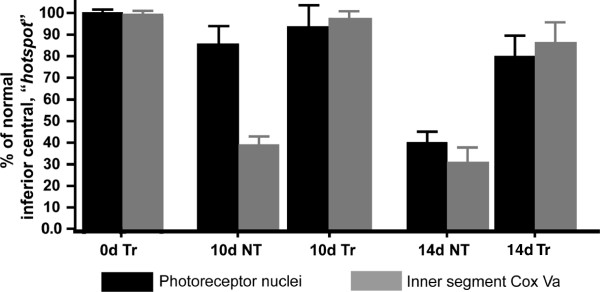
Correlation between the population of photoreceptor nuclei (black bar) and the mitochondrial Cox Va immunostaining (gray bar) in the inner segments. The level of Cox Va expressed by the mitochondria in the inner segments is proportional to the number of photoreceptor nuclei in all groups, except for retinas in 10dNT group. Animals that from 0dNT (nontreated, non-hyperoxic) group were used as baseline controls.